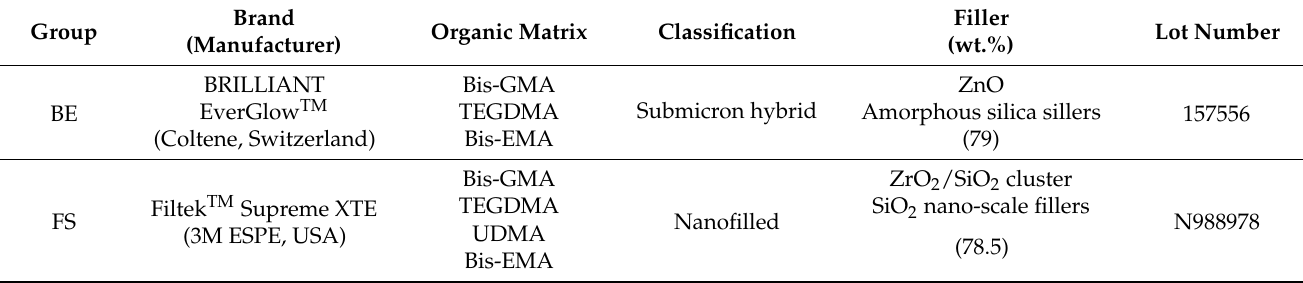
Table 1. Direct restorative dental resin composite